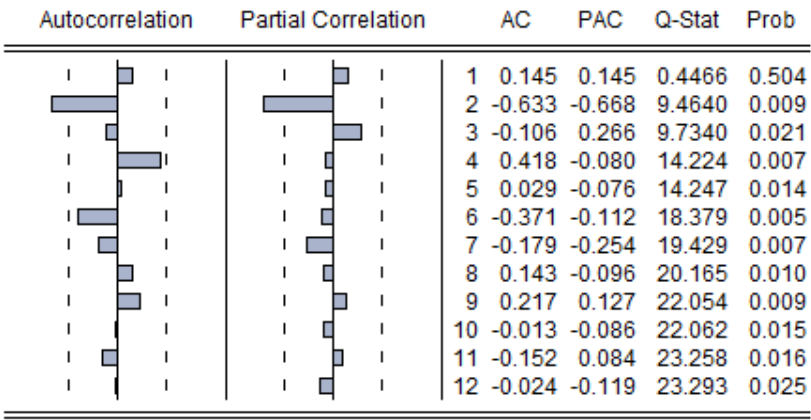
Figure 5. Autocorrelation (AC) and Partial Autocorrelation coefficients (PAC) of MGM-ARIMA.